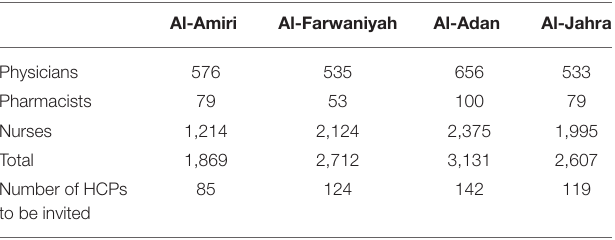
TABLE 1 | Number of HCPs in each hospital, obtained during the preliminary